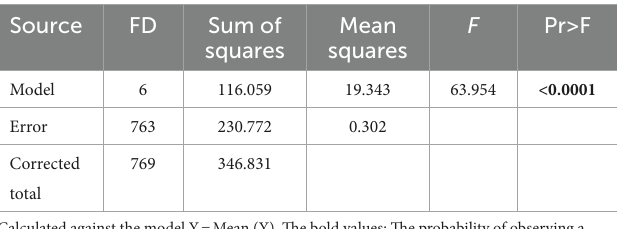
TABLE 10 ANOVA cognitive level/type of activity.